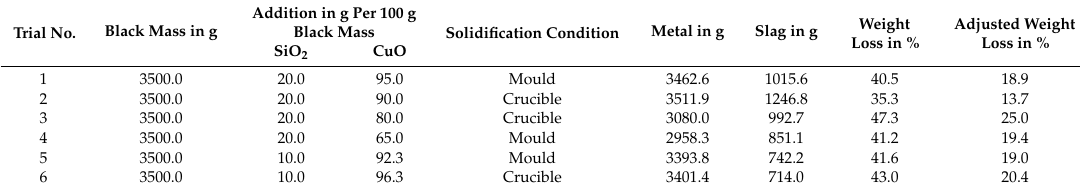
Table 3. Input and output mass of the